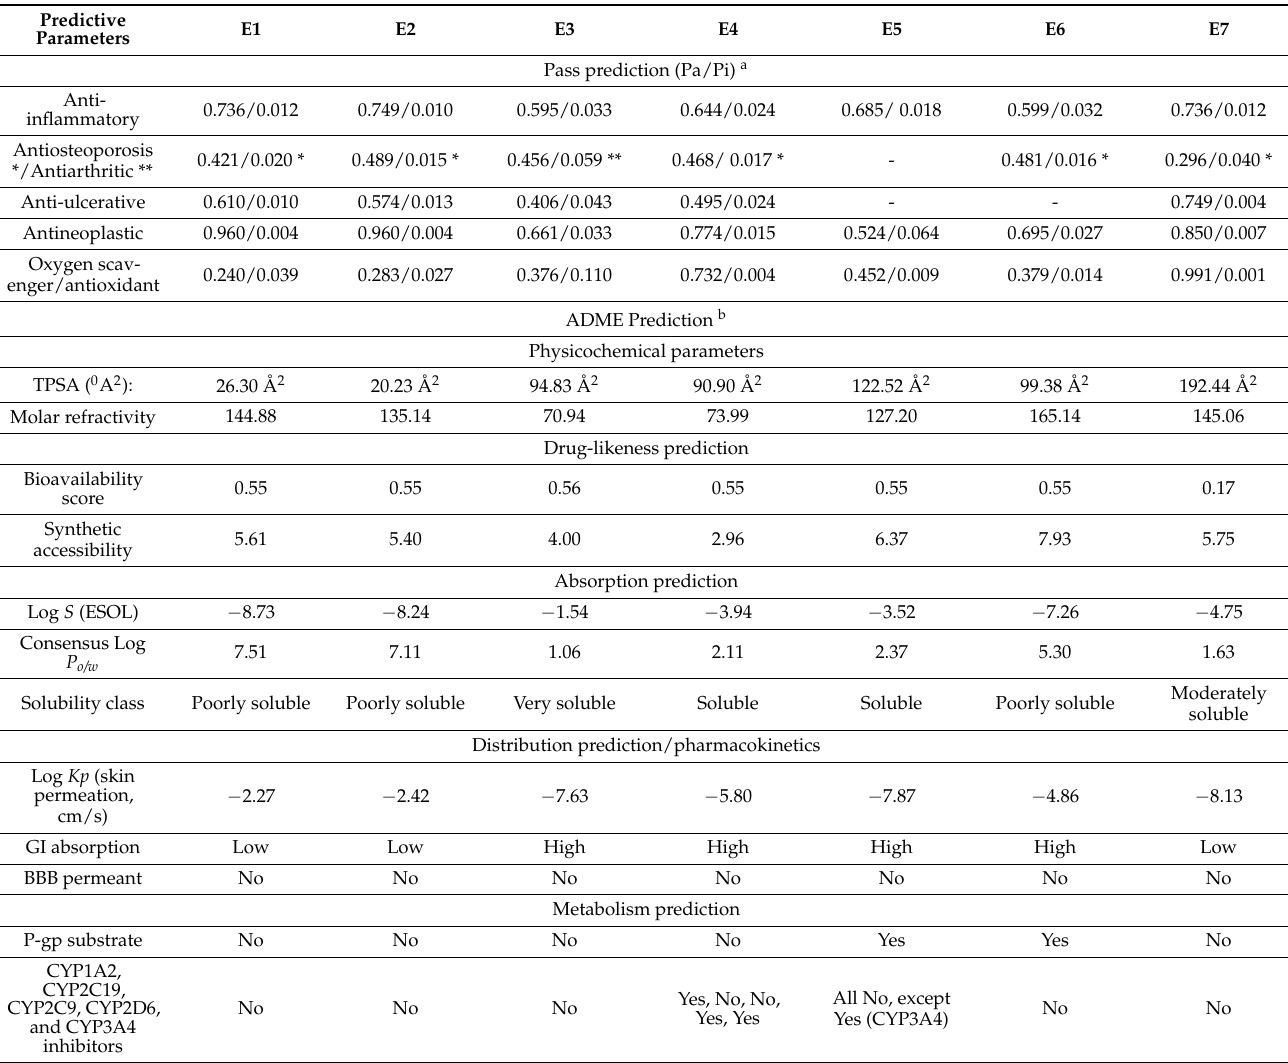
Table 6. In silico physicochemical and pharmacokinetics of the major compounds E1 – E7